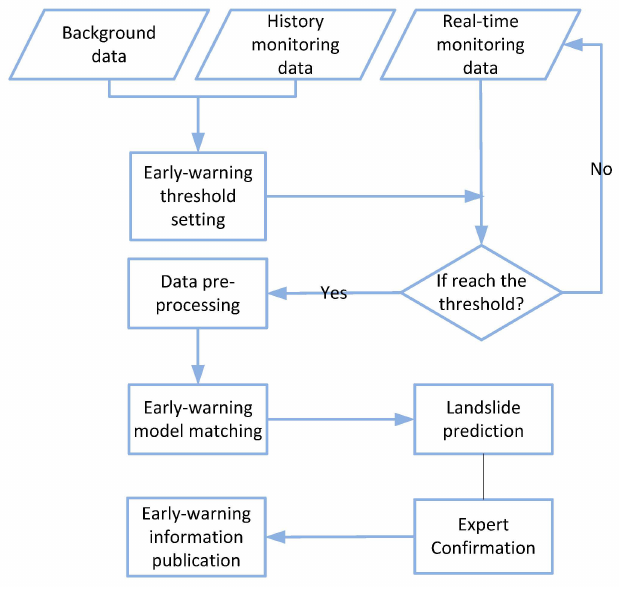
Figure 8. Flow-chart of landslide early warning